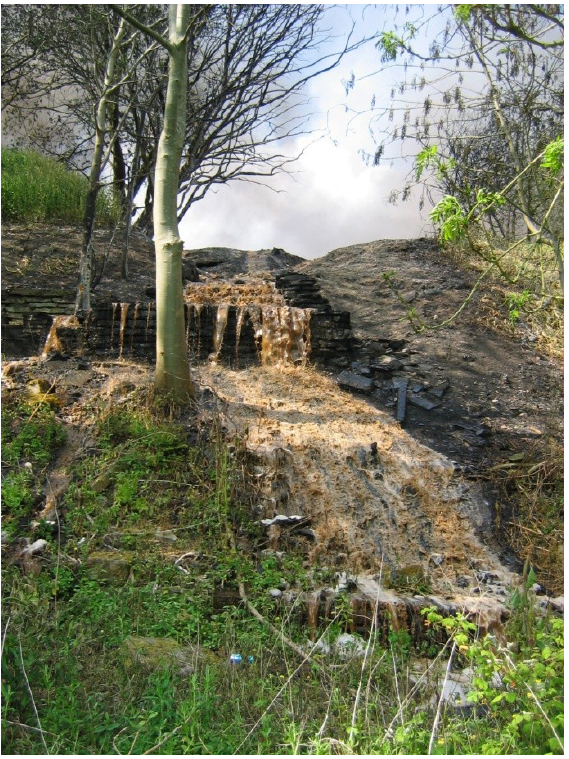
Figure 1. Example of a local stream, near Calderbrook Road in Littleborough, polluted by firewater runoff (photograph taken by Ian Duckworth).